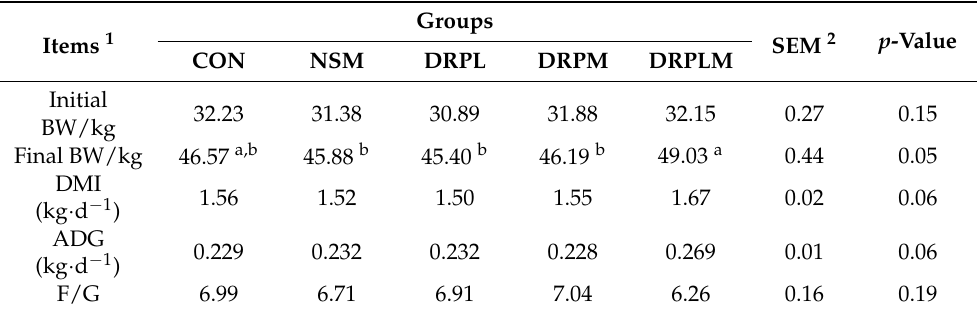
Table 2. Effects of dietary supplementation with rumen-protective amino acids on the growth performance of Hu sheep.